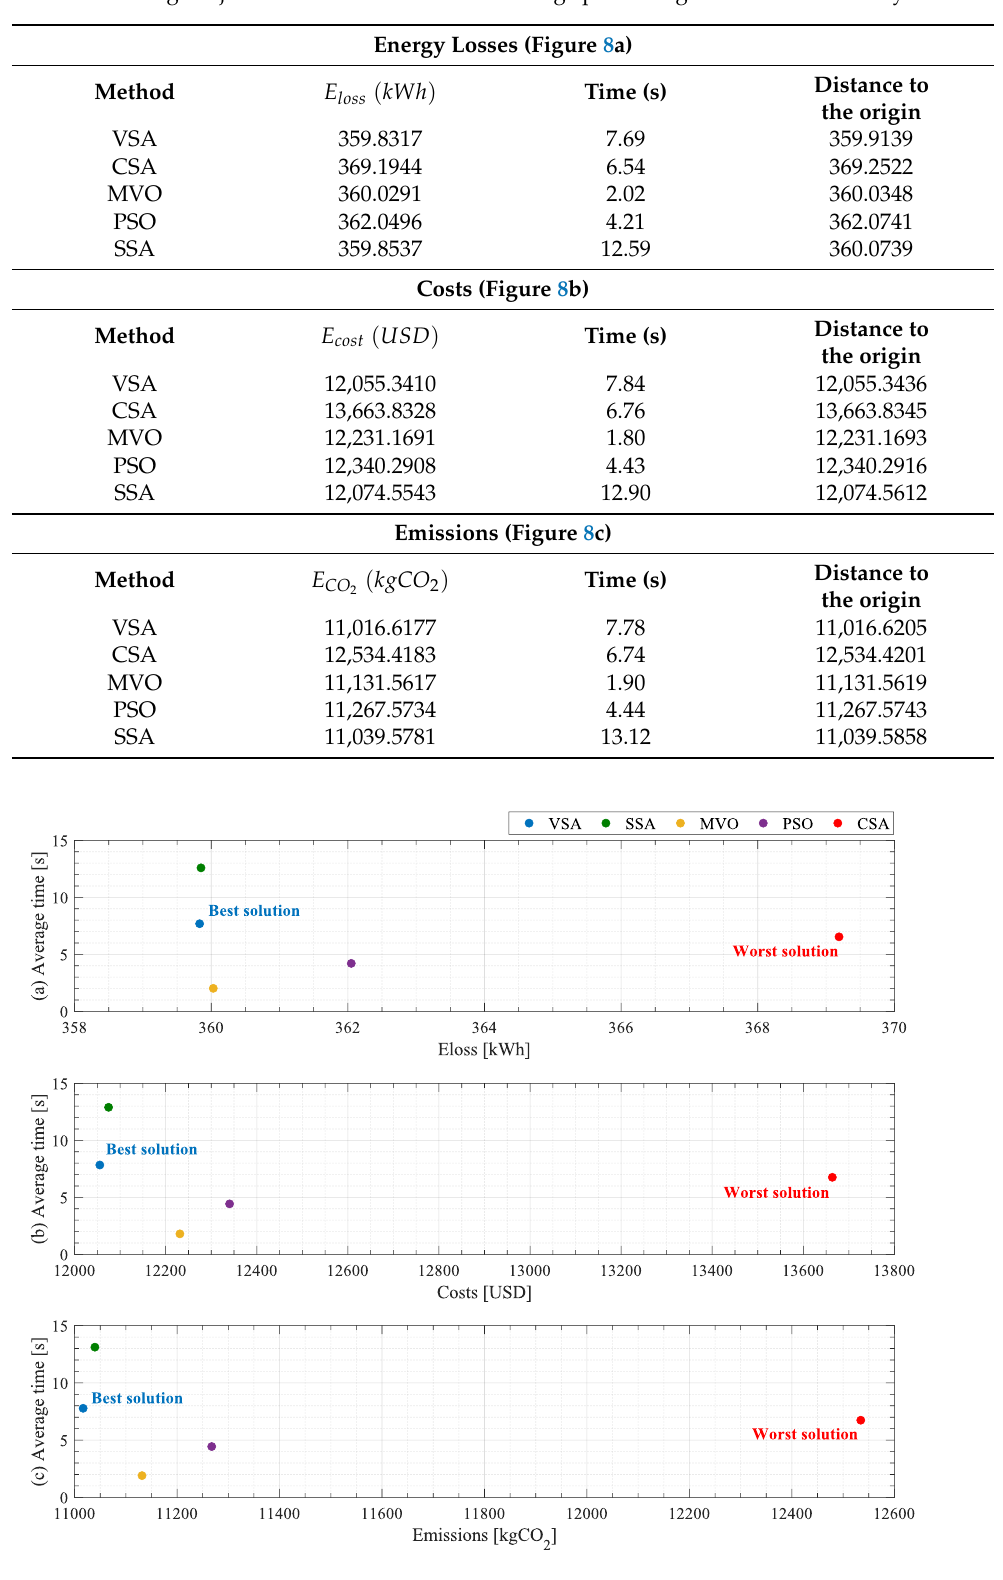
Figure 8. Trade-off provided by the optimization algorithms between objective function and required processing time in the standalone